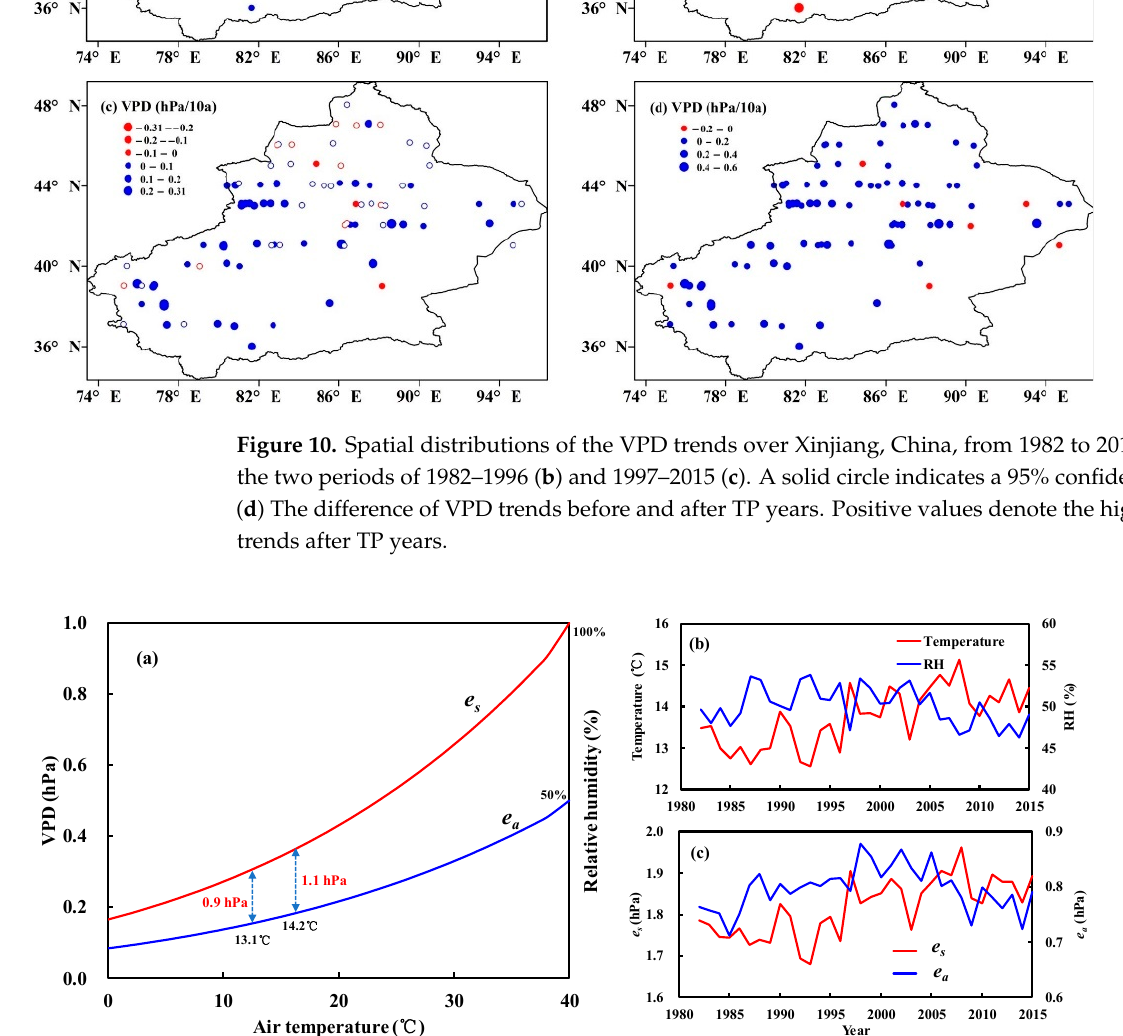
Figure 11. Relationship between VPD (kPa) and relative humidity (%) as a function of air temperature ( a ). The VPD represents the difference between e s (red line, 100% humidity) and e a (blue line, relative humidity remains constant at 20%) at a given temperature. Panels ( b , c ) show the long-term temperature changes, humidity, e s , and e a from 1982 to 2015.